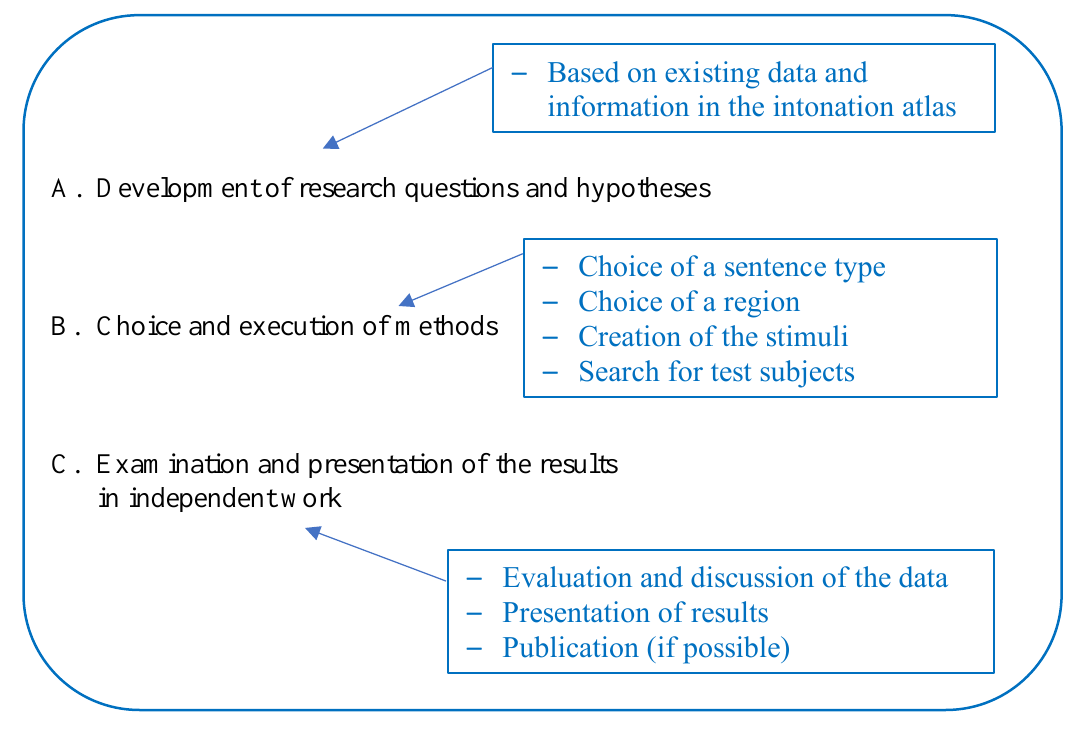
Figure 4. Illustration of the research-led teaching method in intonation